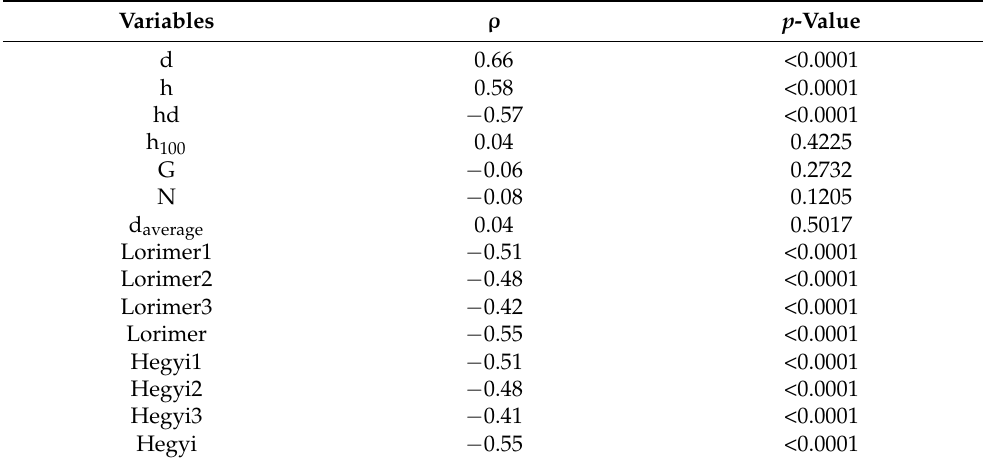
Table 5. Pearson’s correlation between BAI vs. variables of size, site, and competition of the A. angustifolia in a Mixed Ombrophilous Forest in Southern